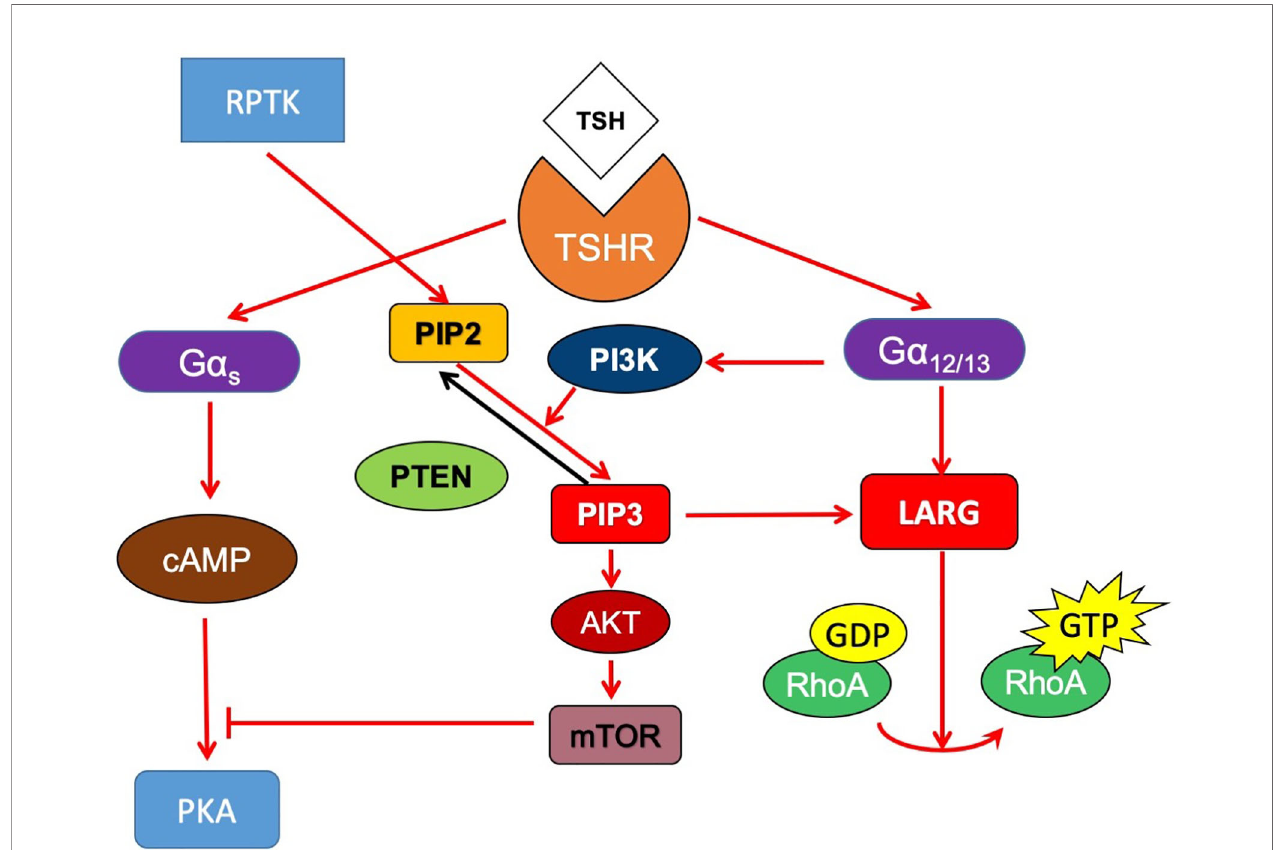
FIGURE 7 | Proposed signaling model of crosstalk between TSHR and PI3K signaling pathway. In thyroid cancer cells, TSHR couples to G a 12/13 , interacts with LARG and then activates RhoA to increase migration. PI3K signaling activation increased LARG levels in cancer cells and altered its localization to facilitate the interaction of LARG with G a 12/13 and enhance TSHR-G a 12/13 signaling. G a 12/13 signaling also might participate with PI3K to inhibit the pathways downstream G a s